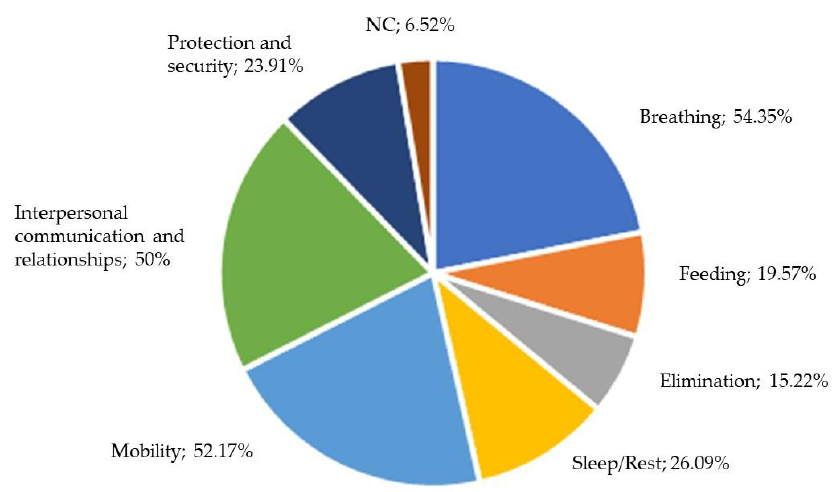
about the total of Figure 3. Results (Q13) on health aspects where robotics can help (percentages are shown each one about the total of participants).